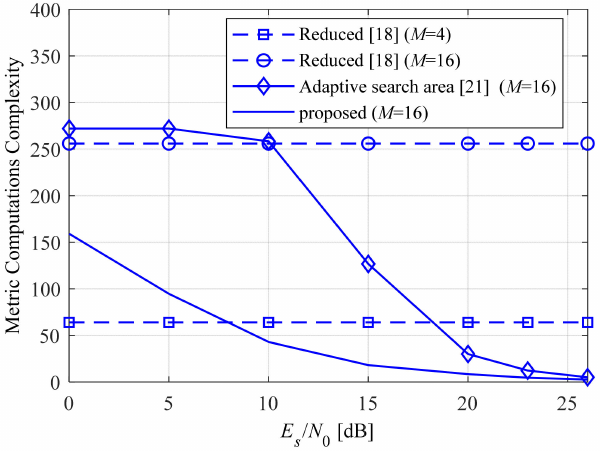
Figure 11. Average metric computation complexity comparisons, N = L = 3 with 16